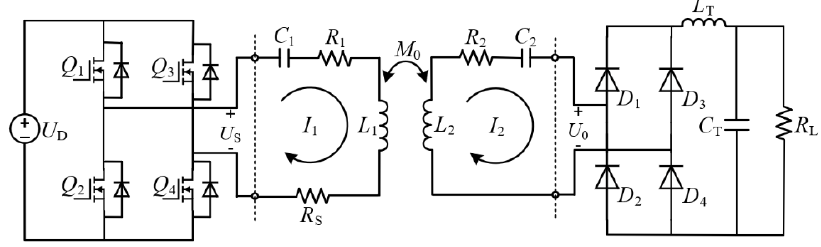
Figure 1. Equivalent circuit diagram of S/S-compensated WPT system.